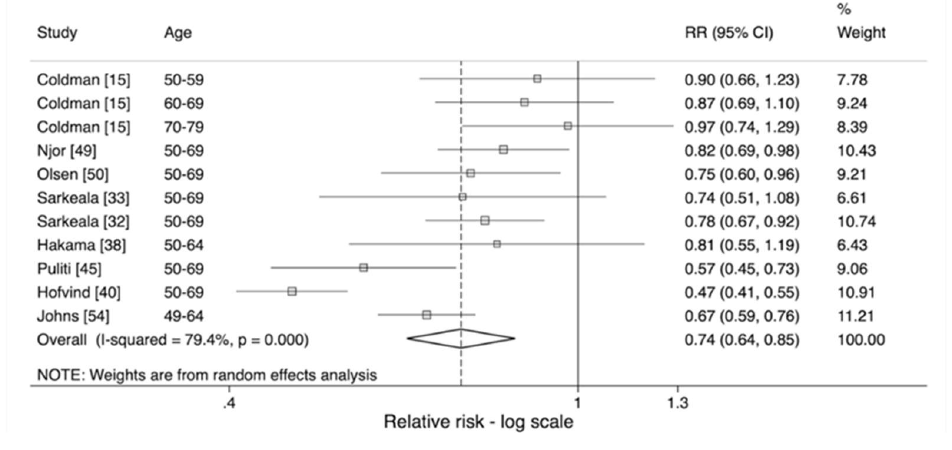
Figure 5. Estimated effect of attendance adjusted for self-selection on risk of breast cancer mortality ( 𝑅𝑅 (cid:2870) ) in women aged 50 and over [15,32,33,38,40,45,49,50,54].